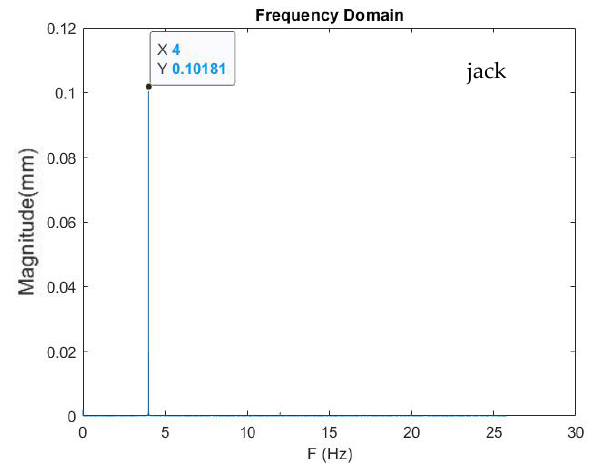
Figure 6. D isplacement report of the jack in a frequency-domain diagram. Figure 6. Displacement report of the jack in a frequency-domain